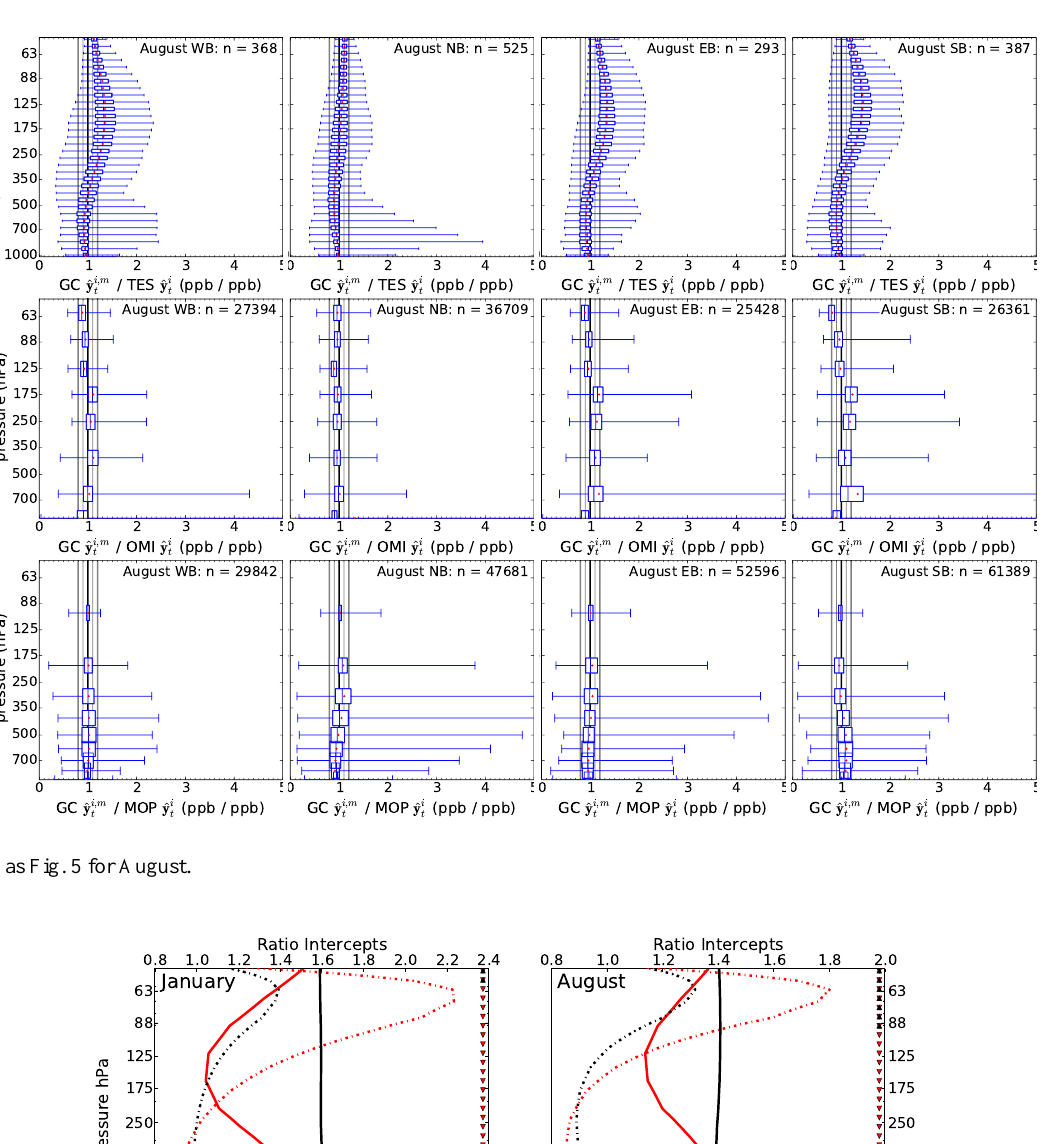
Fig. 7. Linear regression of slope (solid) and intercept (dash-dot) for the ratio of simulated retrieval to TES satellite retrieval as a function of longitude (black) and latitude (red) for January (left) and August (right).